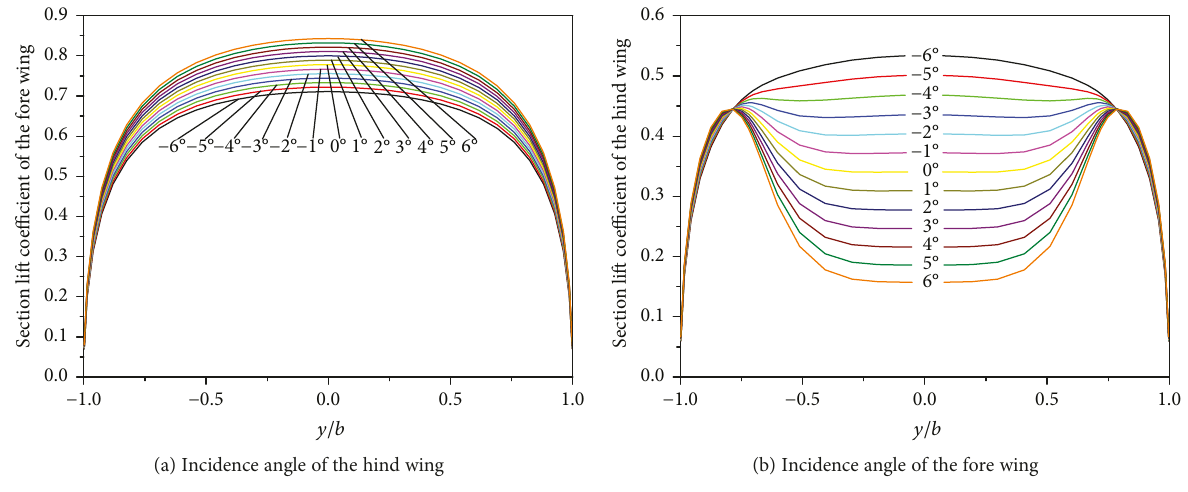
Figure 16: E ff ect of incidence angle on section lift coe ffi cient for tandem wing con fi guration. Table 3: Lift coe ffi cient and coe ffi cient of induced drag with the e ff ect of incidence angle and wingspan.